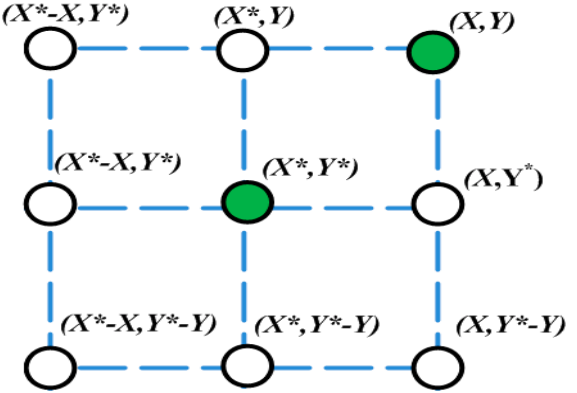
Figure 1. All possible positions for two-dimensional optimization problem.